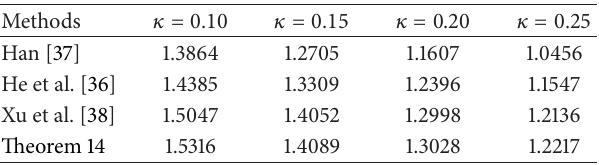
Table 2: Maximum upper bound of 𝑑 with 𝜏 = 1.0 and different parameter 𝜅 .